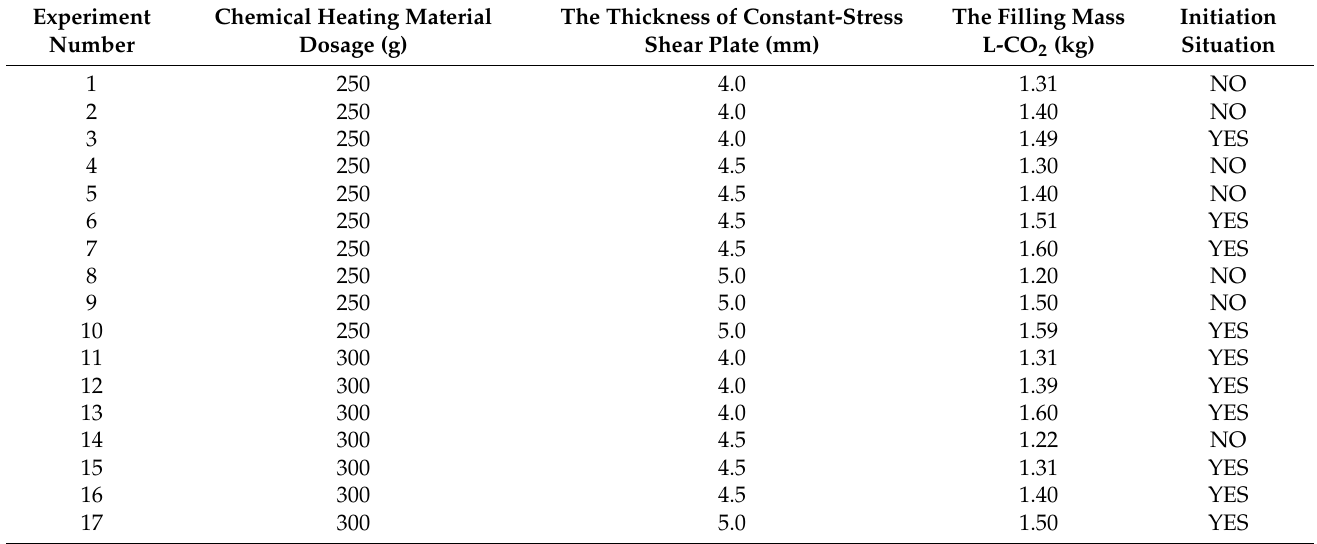
Table 1. The values of the experimental